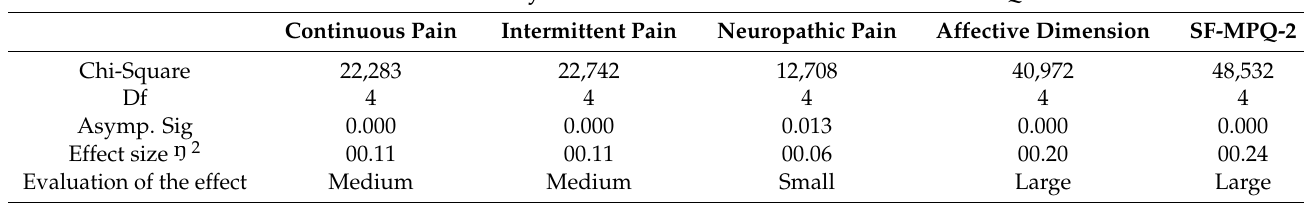
Table 5. Association of the total SF-MPQ-2 score with patient